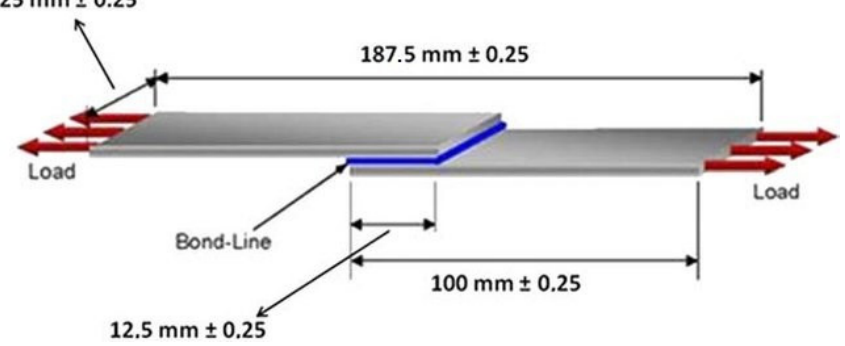
Figure 1. The dimension of the specimen for the lap-shear test [11].